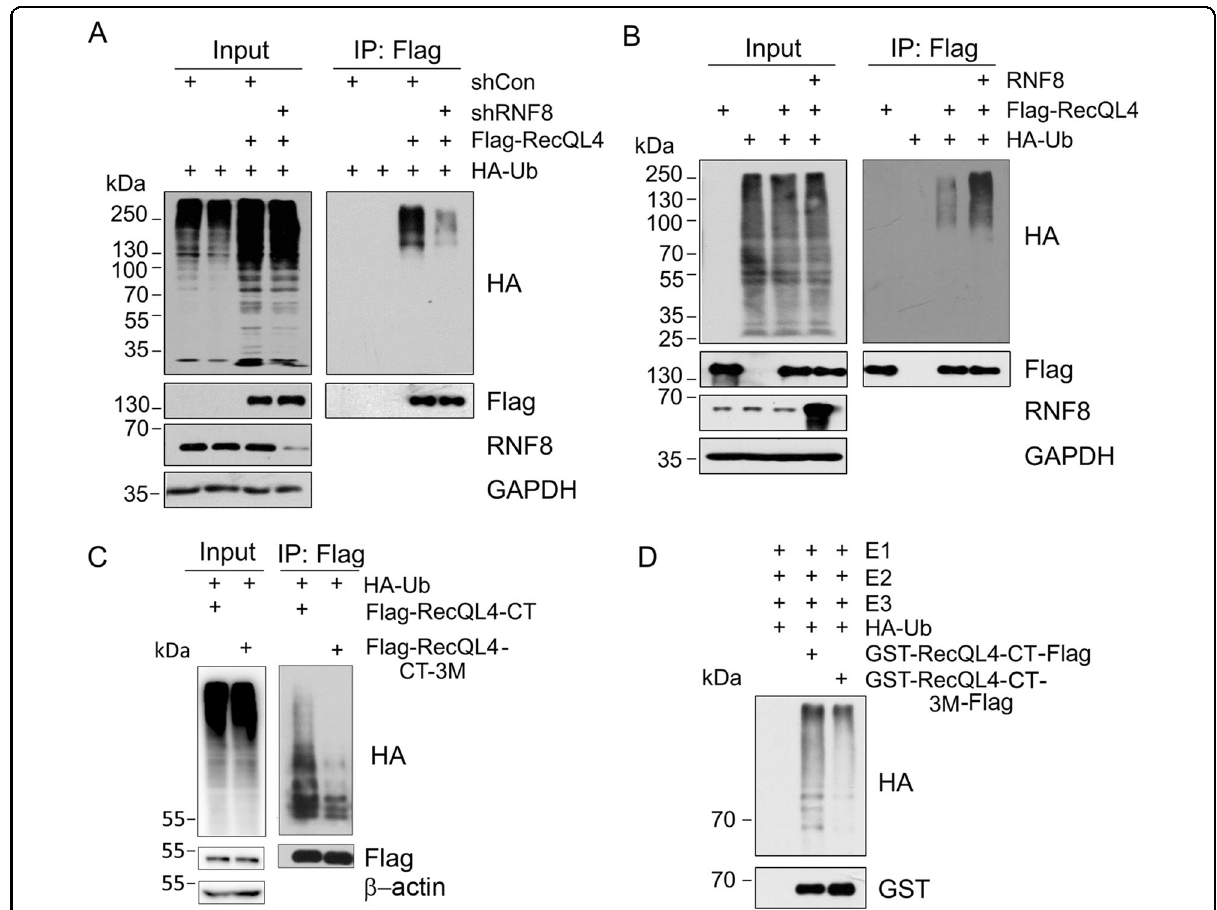
Fig. 2 RecQL4 is the substrate of RNF8. A RecQL4 ubiquitination level was decreased upon RNF8 depletion. U2OS cells were transfected with Flag- RecQL4 plasmid, followed by control/RNF8 shRNA and HA-Ub plasmids. Immunoprecipitation was performed on the cell lysates using anti-Flag (M2) beads, and RecQL4 ubiquitination level was determined by western blotting analysis with anti-HA antibody. B RNF8 promotes RecQL4 ubiquitination in vivo. U2OS cells were transfected with Flag-RecQL4, HA-Ub, and RNF8 plasmids. Empty vector was used as control. C , D RecQL4 CT mutant (3M: K876R-K2048R-K1101R) showed a markedly decreased ubiquitination level relative to wild-type RecQL4 CT in both in vivo and in vitro ubiquitination